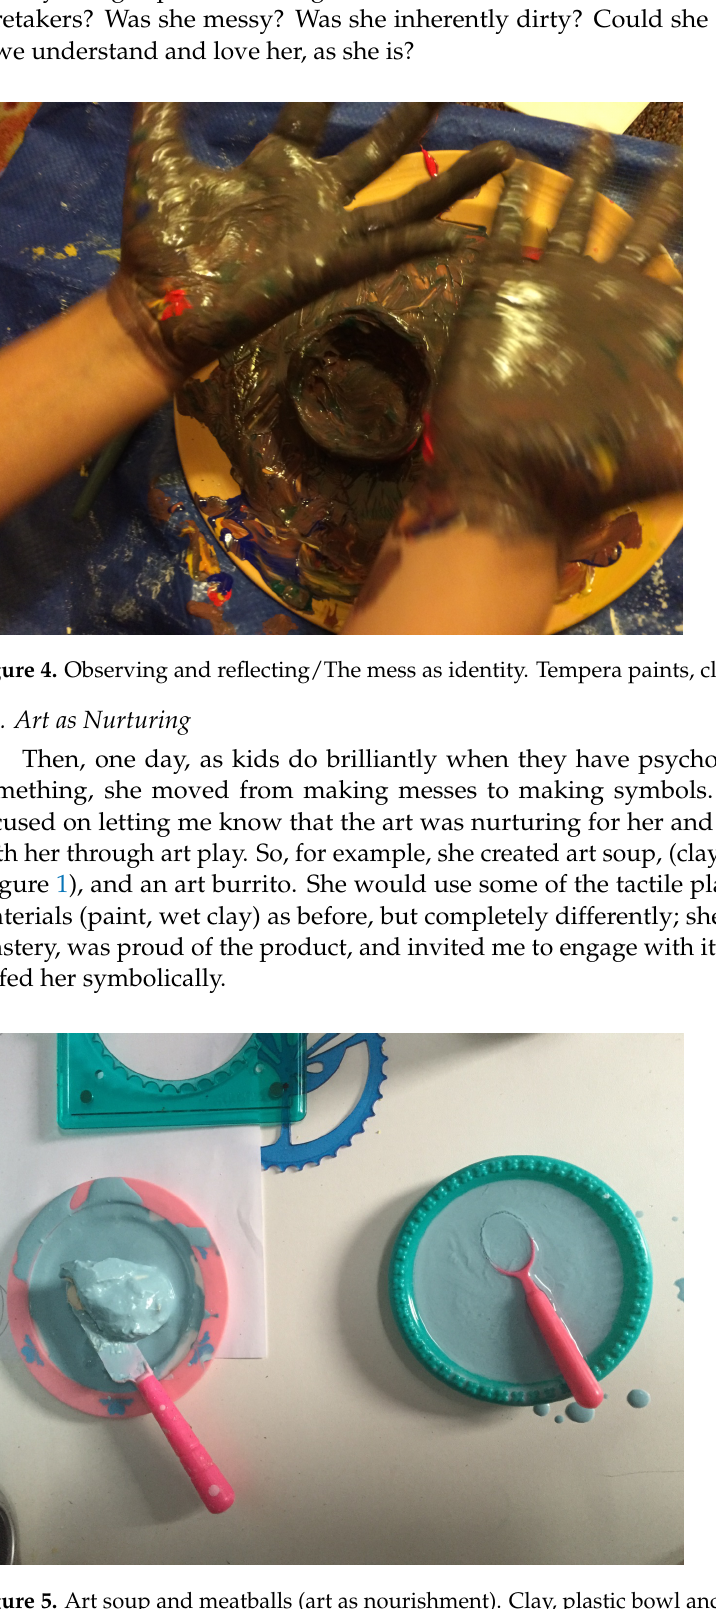
Figure 5Figure 5. Art soup and meatballs (art as nourishment). Clay, plastic bowl and spoons, tempera